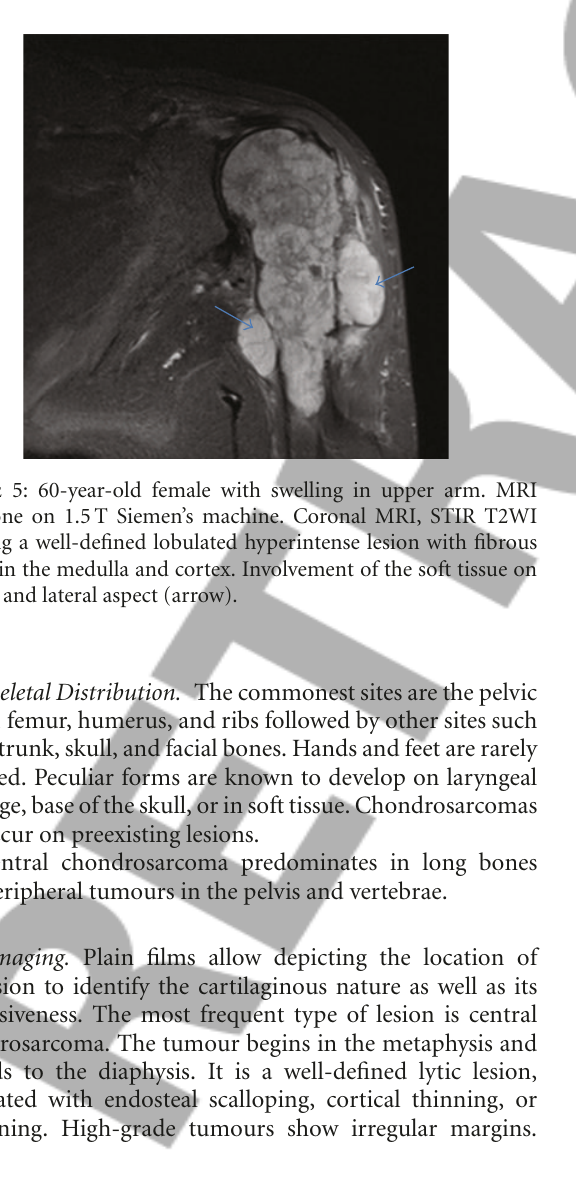
Figure 7: 60-year-old female with swelling in upper arm. MRI was done on 1.5 T Siemen’s machine. Coronal T1WI showing large lobulated lesion which is hypointense in signal